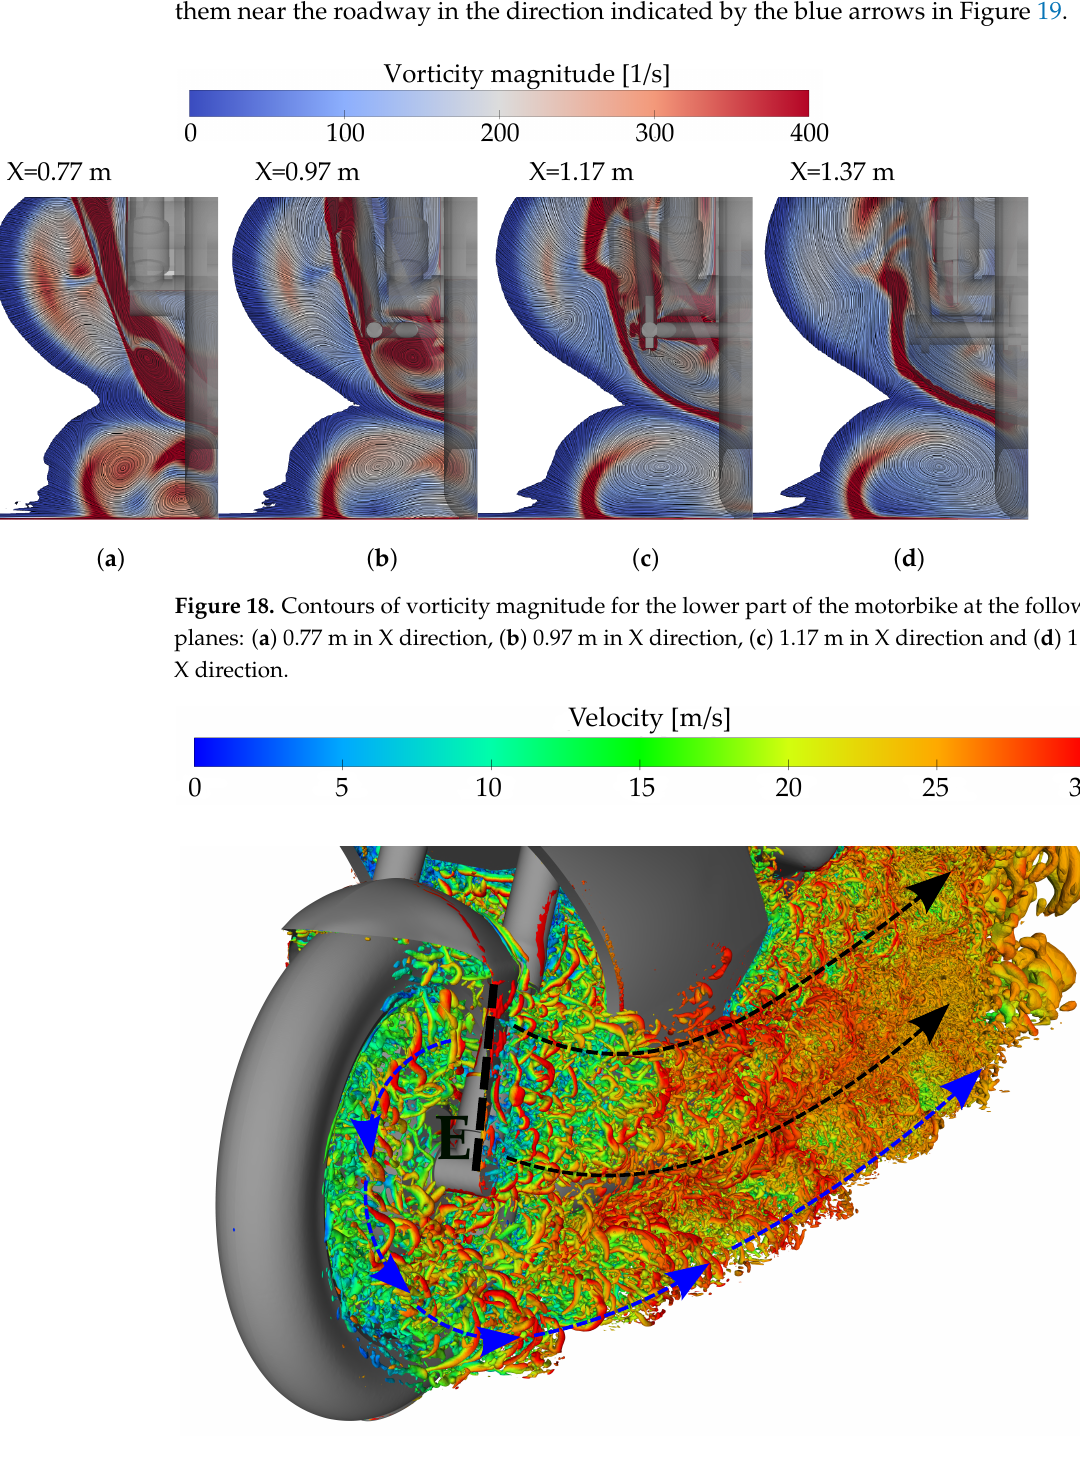
Figure 19. Isosurface of the normalised Q-criterion equal to 0.15 coloured by velocity values together with the characteristic zone ( E )